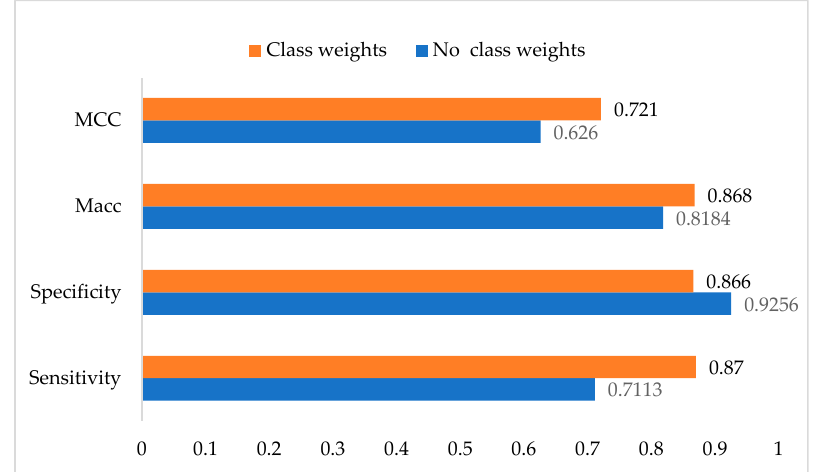
Figure 5. Performance comparison between the default loss function and loss function with class weights. The default loss function is with the equal class weights for normal and abnormal samples, while the class weights-based method sets 2.73 for abnormal samples and a small value 0.63 to the normal samples.